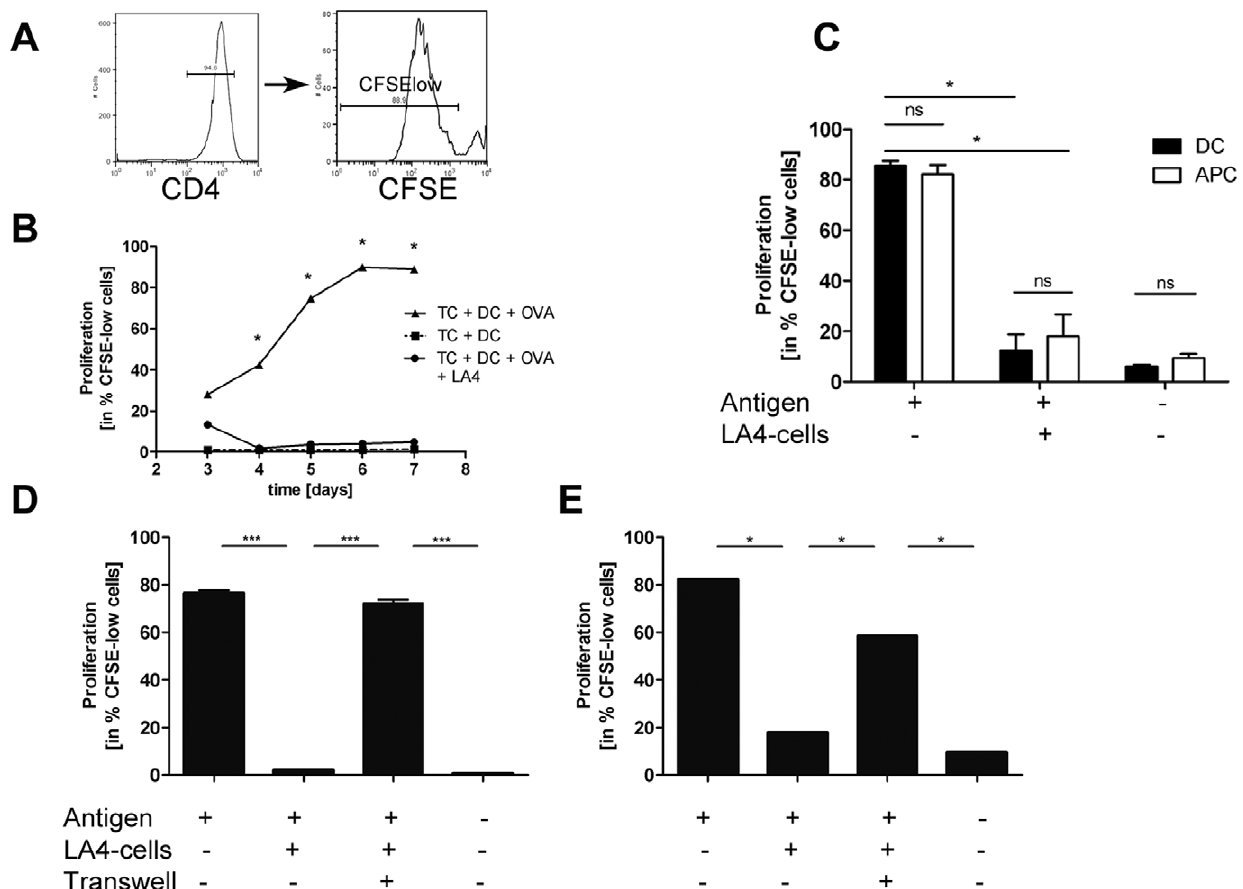
Figure 2. Airway epithelial cells suppress antigen-specific T cell proliferation. A: Gating strategy for assessment of T cell proliferation by CFSE dilution. All CD4 + cells having a lower CFSE intensity than non-proliferated control cells were designated as ‘‘CFSE-low’’ cells. Proliferation of OVA-specific DO11.10 T cells was induced by DC-mediated OVA-presentation or T cell-depleted splenocyte (=APC) presentation of pOVA for the indicated time (B) or on day 4 (C–E). Cultures w/o antigen served as controls. Epithelial-mediated suppression was assessed in co-culture with the LA4-cell line, a murine, type II pneumocyte cell line. B: Pulmonary epithelial cells inhibit antigen-induced T cell proliferation. C: Epithelial-mediated suppression of T cell proliferation is independent from type of antigen-presenting cell. Epithelial-mediated suppression of T cell proliferation is almost entirely dependent on cell-contact of epithelial cells with T cells and DC (D) or APC (E). TC = T cell, DC = dendritic cell, OVA = Ovalbumin, pOVA = OVA-peptide, APC = T cell-depleted splenocyte, ns = not significant. *p , 0.05 compared to all other variables tested or as designated by bars, calculated by Mann-Whitney-U test. 2C: ***p , 0.001 1way ANOVA with Bonferroni’s Multiple Comparison Test Representative experiments of n=5–12